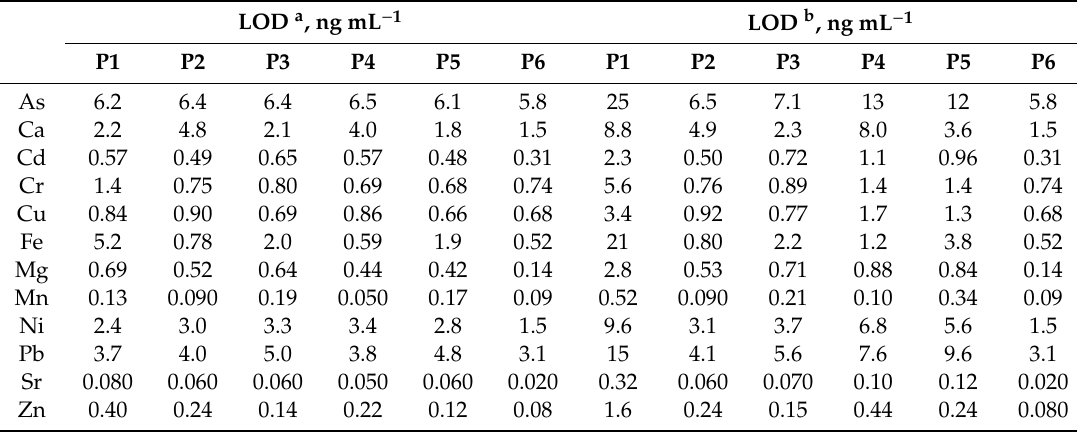
Table 1. Limits of detection (LODs) achievable with inductively coupled plasma optical emission spectrometry (ICP OES) combined with di ff erent sample preparation procedures, i.e., reference (P1) and alternative (P2–P6)